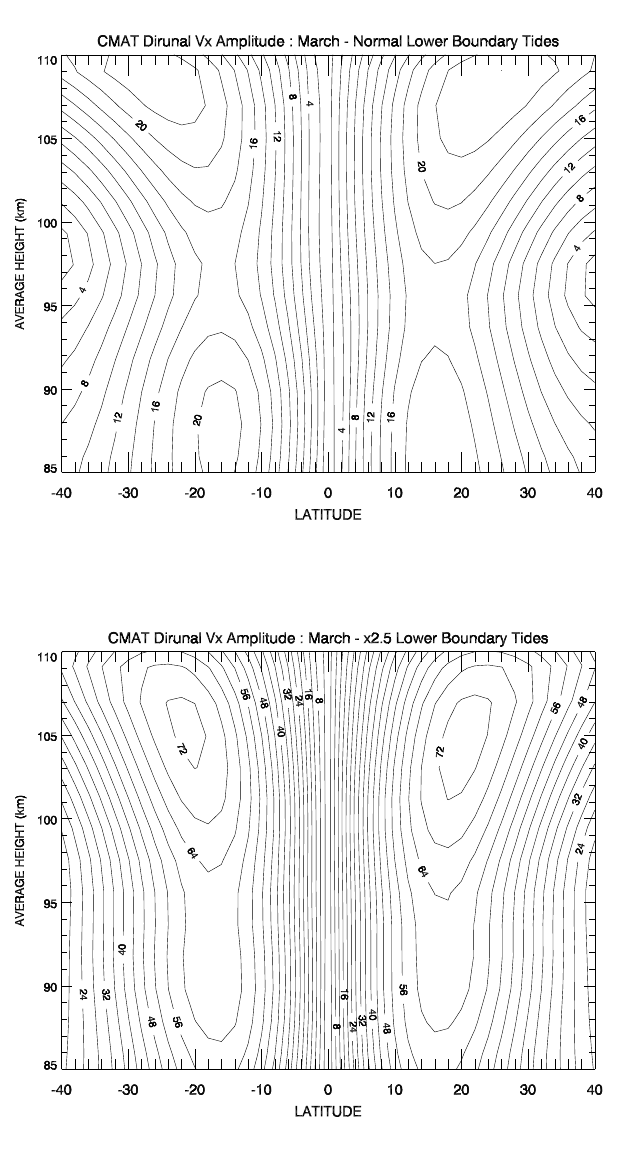
Fig. 5. Meridional winds (ms − 1 ) at 12:00LT for March, as mea- sured by HRDI (top) (from Yudin et al., 1997), with southward winds shaded, and the diurnal amplitude structure of meridional winds (ms − 1 ) as measured by WINDII (bottom) (from Akmaev et al.,